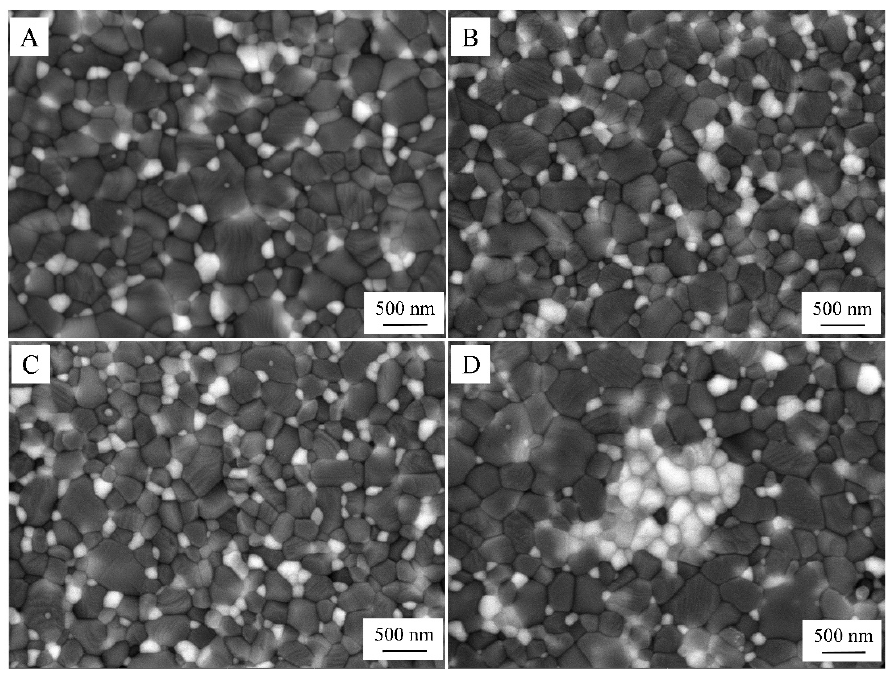
Figure 5. SEM images of polished surface of 0-G ( A ), 0.5-G ( B ), 1-G ( C ), and 5-G (D ) sintered com-